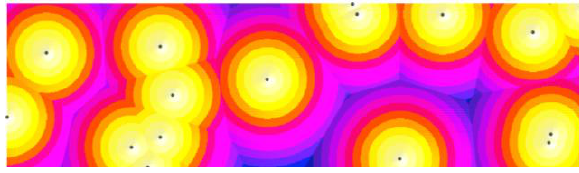
Figure 3. Euclidean Distance Map